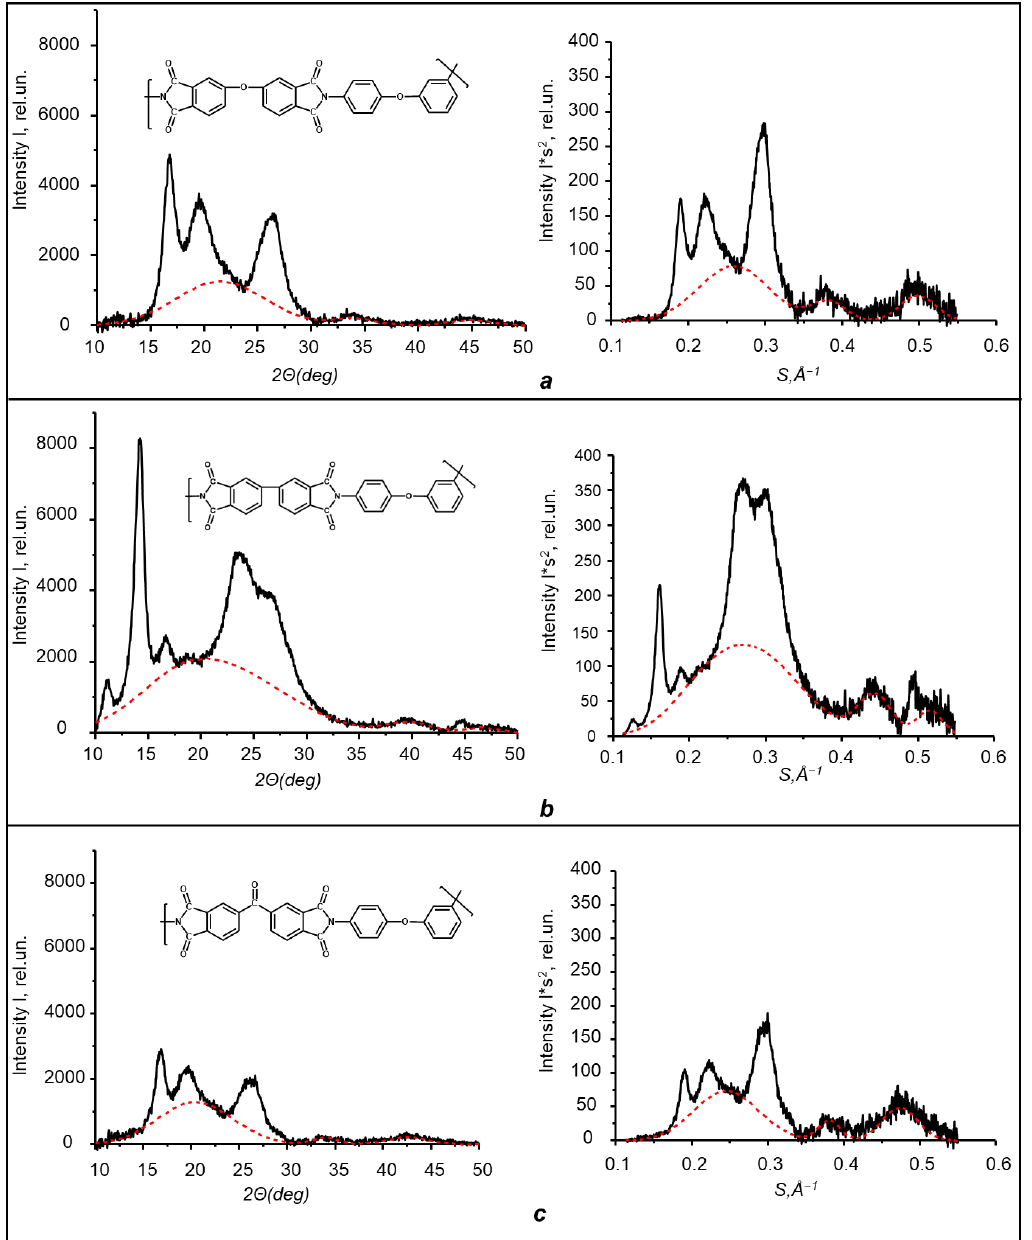
Figure 10. The WAXS diffractograms of PI-ODPA ( a ), PI-BPDA ( b ) и PI-BZP ( c ). Experimental WAXS curves are black. Calculated scattering curves from amorphous (disordered) phase are red.